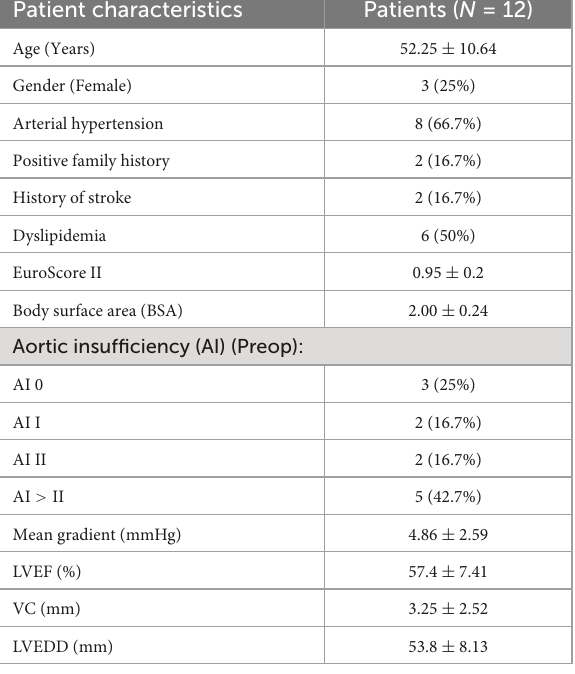
TABLE 1 Patient demographics and pre-operative echocardiographic data.